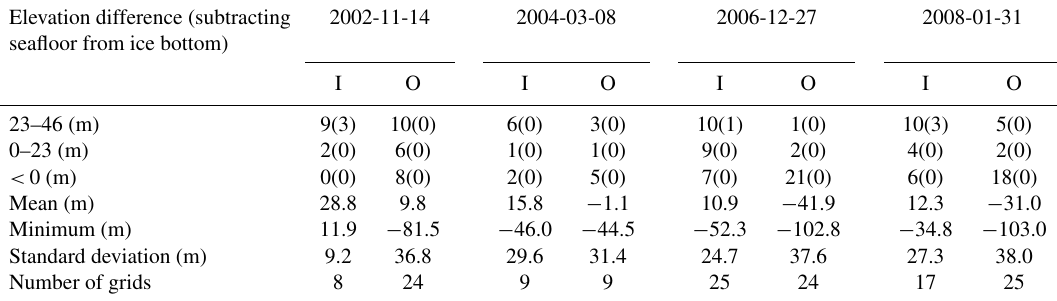
Table 2. Statistics of grounding grids inside the MIT or grounding potentials outside of the MIT (I: inside the thick black line, Fig. 6; number in brackets indicates how many grids are located inside the 2000 Mertz boundary; O: between the black and gray lines, Fig. 6) from 14 November 2002, 8 March 2004, 27 December 2006 and 31 January 2008, respectively. Each grid covers an area of 1km 2 . The mean, minimum and standard deviation are calculated without considering those fallen inside the 2000 Mertz boundary and only include those out of the 2000 Mertz boundary with an elevation difference less than